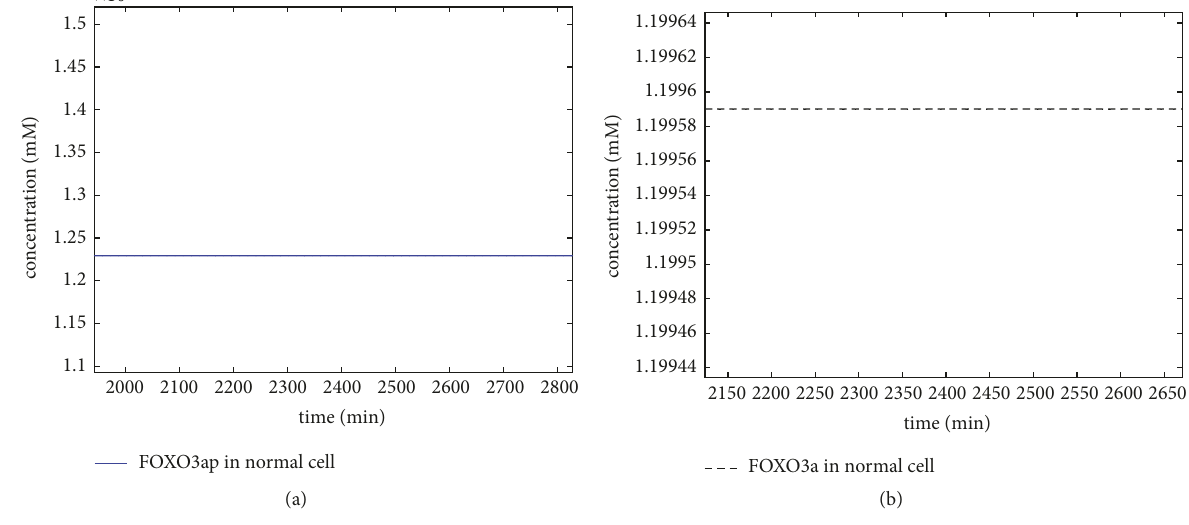
Figure 4: The FOXO3ap (a) and FOXO3a (b) concentration in the normal